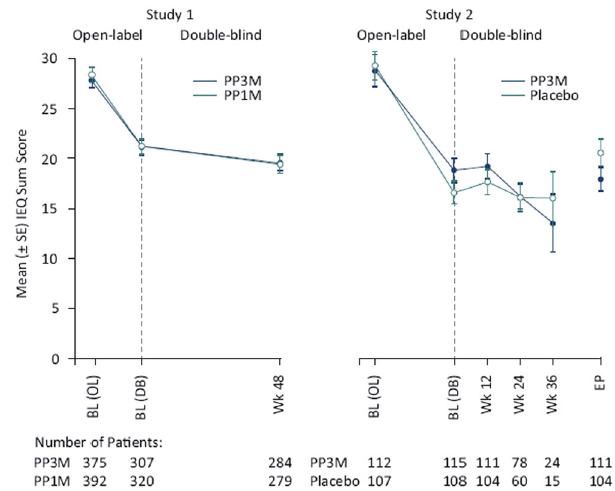
Fig. 1 IEQ Total score over time. mITT (DB) analysis set (modi fi ed intent to treat, all patients randomized who received at least